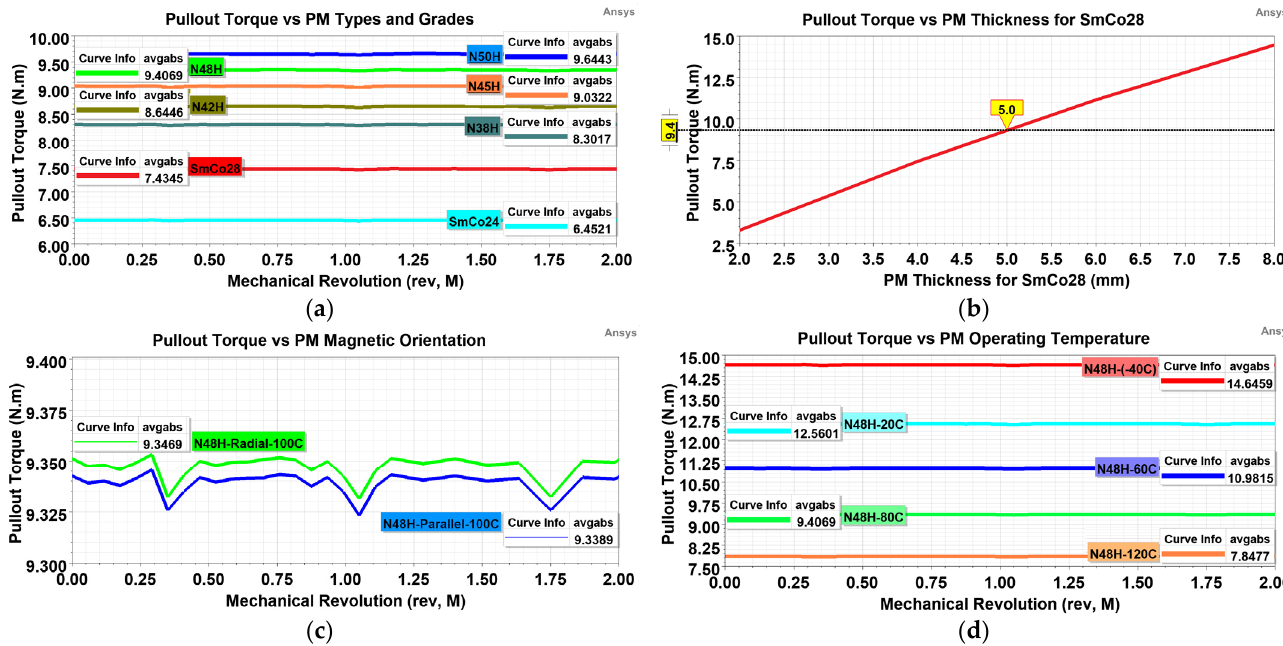
Figure 14. Effect of PM: ( a ) Grade; ( b ) Type; ( c ) Magnetic orientation; ( d ) Operating temperature.